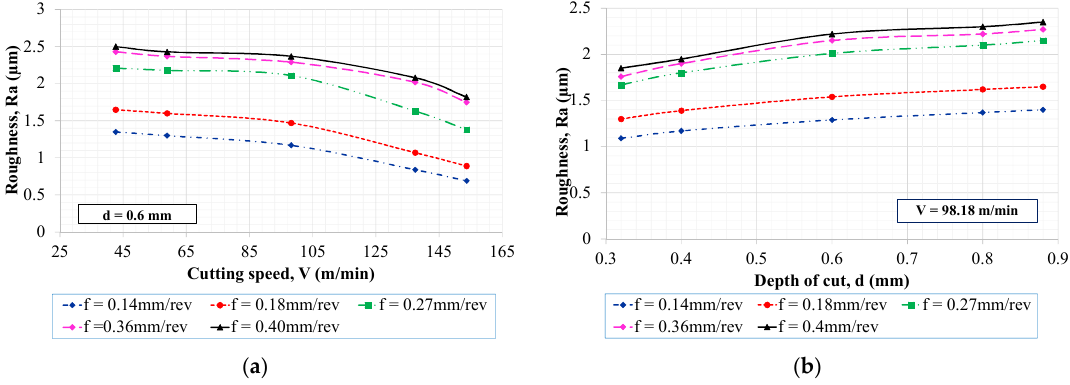
Figure 5. The effect of ( a ) cutting speed ( b ) depth of cut on surface roughness for different feed.